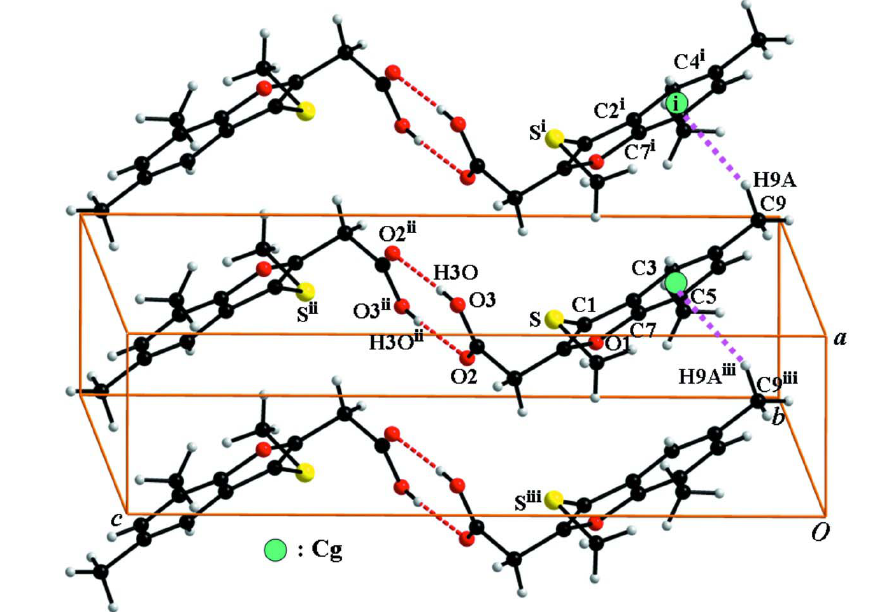
Figure 2 A portion of the crystal packing showing C—H··· π interaction and hydrogen bonds (dotted lines). Cg denotes the C2–C7 ring centroid [symmetry codes: (i) x + 1, y , z ; (ii) - x + 1, - y + 2, - z + 1; (iii) x - 1, y , z